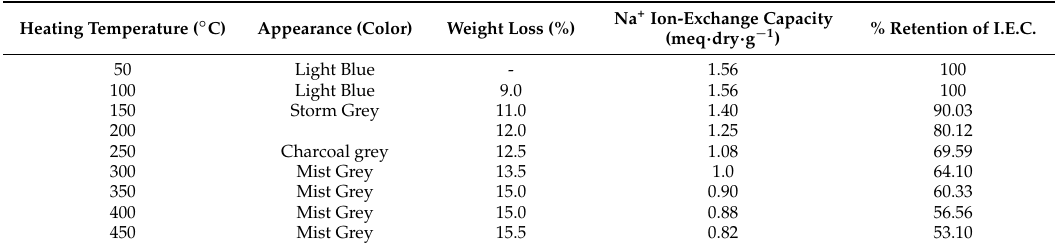
Table 4. Effect of temperature on ion-exchange capacity (IEC) of graphene Th(IV) phosphate composite cation-exchanger on heating.